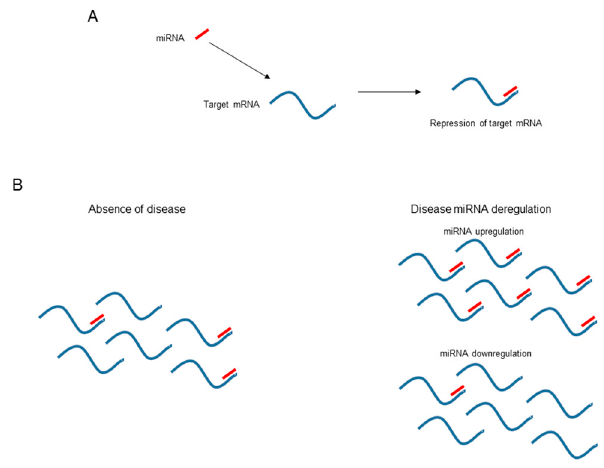
Figure 1. Molecular mechanism of the repressor activity of microRNAs. ( A ) miRNAs bind target mRNAs and repress their expression. ( B ) The stoichiometry of target mRNAs and miRNAs governs mRNA expression. In the presence of a disease state, the expression of a miRNA may be upregulated or downregulated and, consequently, the miRNA and target stoichiometry may change and the corresponding mRNA expression be altered. Although not shown in this figure, the opposite situation can also occur; disease may alter the expression of an mRNA and modify the amount of free miRNA, which may have an effect elsewhere.